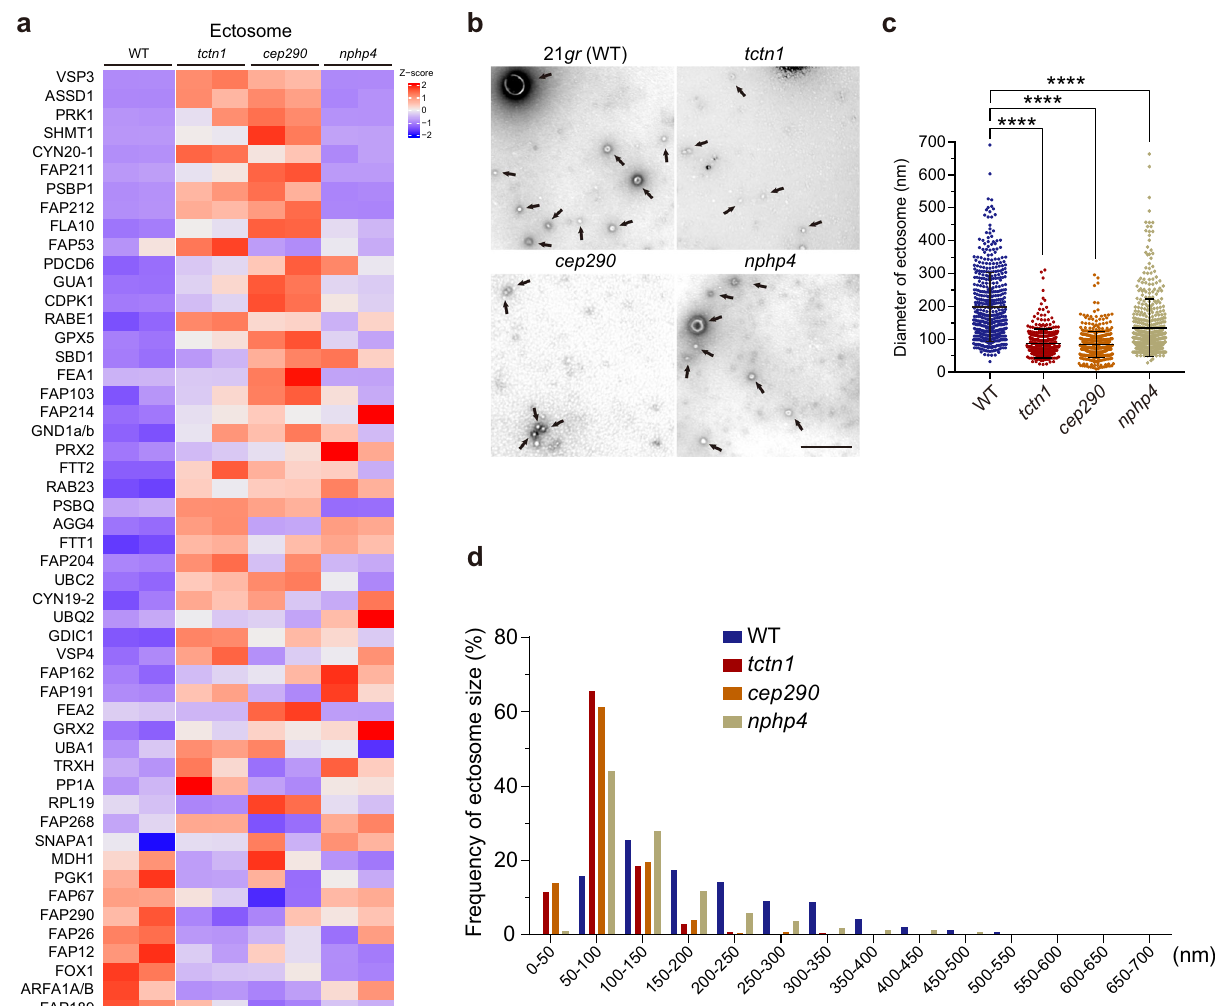
Fig. 6 The formation of ciliary ectosomes is regulated by the integrity of the TZ during gamete mating events. a Heatmap of representative ectosome- related proteins identi fi ed from ciliary proteomics analysis of cilia from WT, tctn1 , cep290 , and nphp4 cells (two replicates for each strain, column). Representative proteins were selected from the mass spectrometry data in Supplementary Fig. 6a. The Z – score is shown by color key in the heatmap. b Negative stain transmission electron micrographs of puri fi ed ciliary ectosomes (black arrows) from gametes in the mating process. 21 gr (WT), ectosomes from mating supernatant of 21 gr × 6145c; tctn1 , ectosomes from mating supernatant of tctn1 × 6145c; cep290 , ectosomes from mating supernatant of cep290 × 6145c; nphp4 , ectosomes from mating supernatant of nphp4 × 6145c. Scale bar, 500 nm. c Scatter plot showing the diameters of ectosomes shedded from the cilia of different mating gametes. The sizes of the ectosomes are the mean ± SD ( n = 500) described in b . Statistical signi fi cance was determined with an unpaired t test. **** P < 0.0001 by two tailed. d Graph showing the distribution of ciliary ectosomes of different